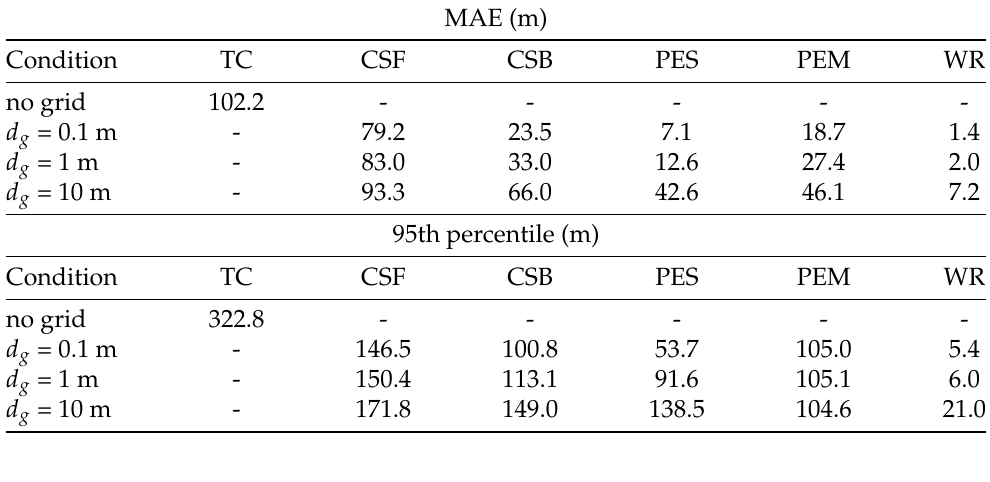
Table 2. Mean absolute error (MAE) and 95th percentile under different conditions in the field exper- iment.